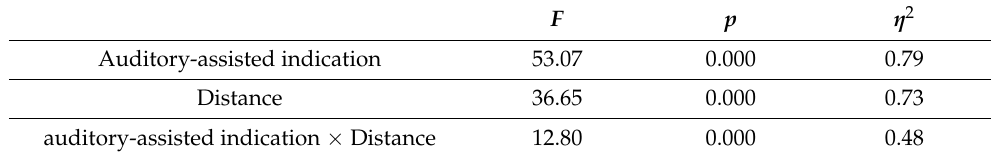
Table 6. Results of ANOVA.